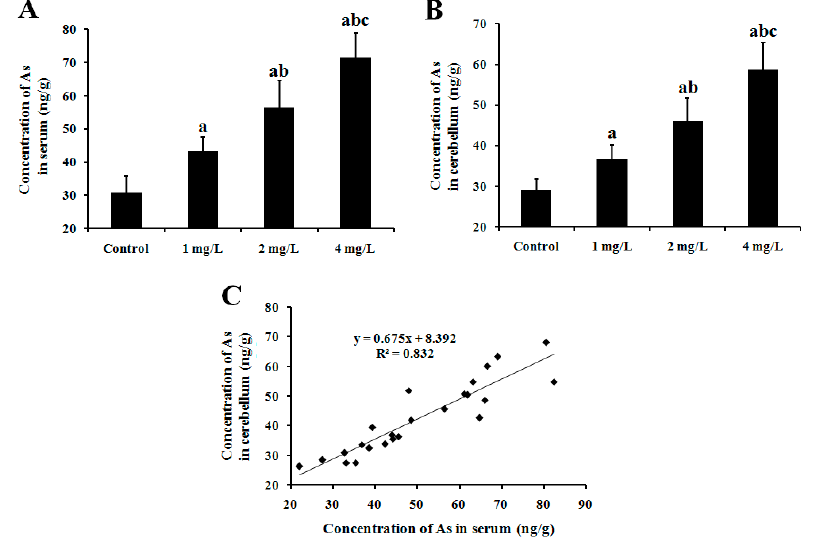
Figure 1. Concentration of As in serum ( A ) and cerebellum ( B ) of mice. Adult male mice exposed to 0, 1, 2, and 4 mg/L As 2 O 3 in drinking water for 60 days. After the treatment, the concentration of As in serum and cerebellum of mice was determined by ICP-MS. Data obtained from six separate analyses are expressed as mean ± SD ( n = 6 for each group); ( A , B ) a p < 0.05, significantly different compared with the control group; b p < 0.05, significantly different compared with the 1 mg/L As 2 O 3 -treated group; c p < 0.05, significantly different compared with the 2 mg/L As 2 O 3 -treated group; ( C ) Correlation analysis. R 2 = 0.822, p < 0.01. Regression equation was y = 0.675 x +